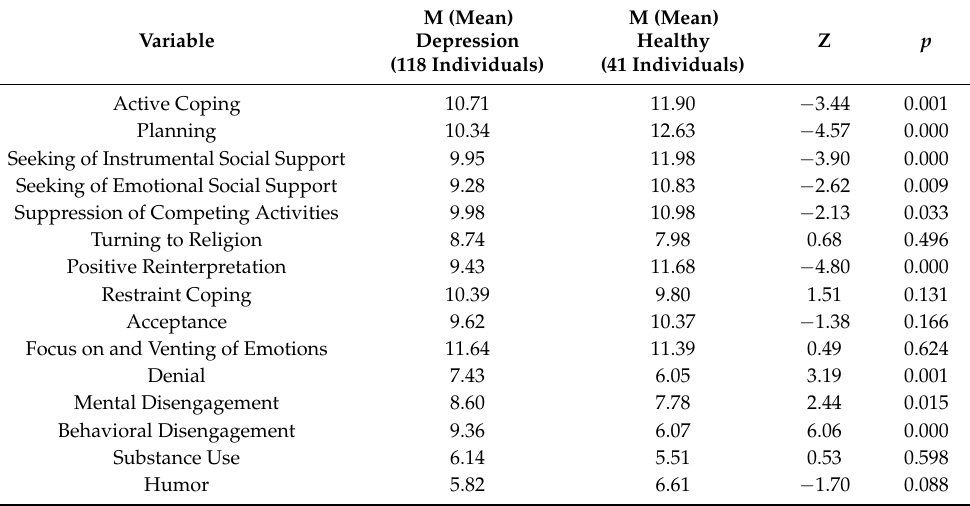
Table 2. Difference between patients with depression and healthy subjects in stress coping